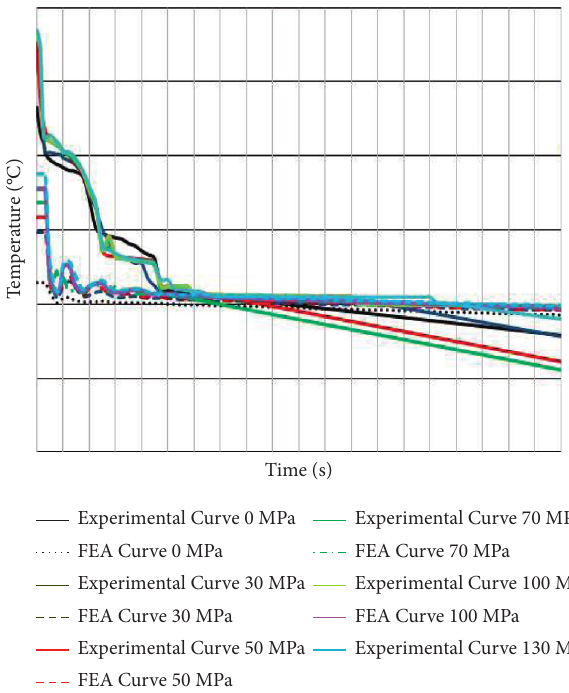
Figure 5: Comparison of experimental and FEA curves for Al AA6082/SiC